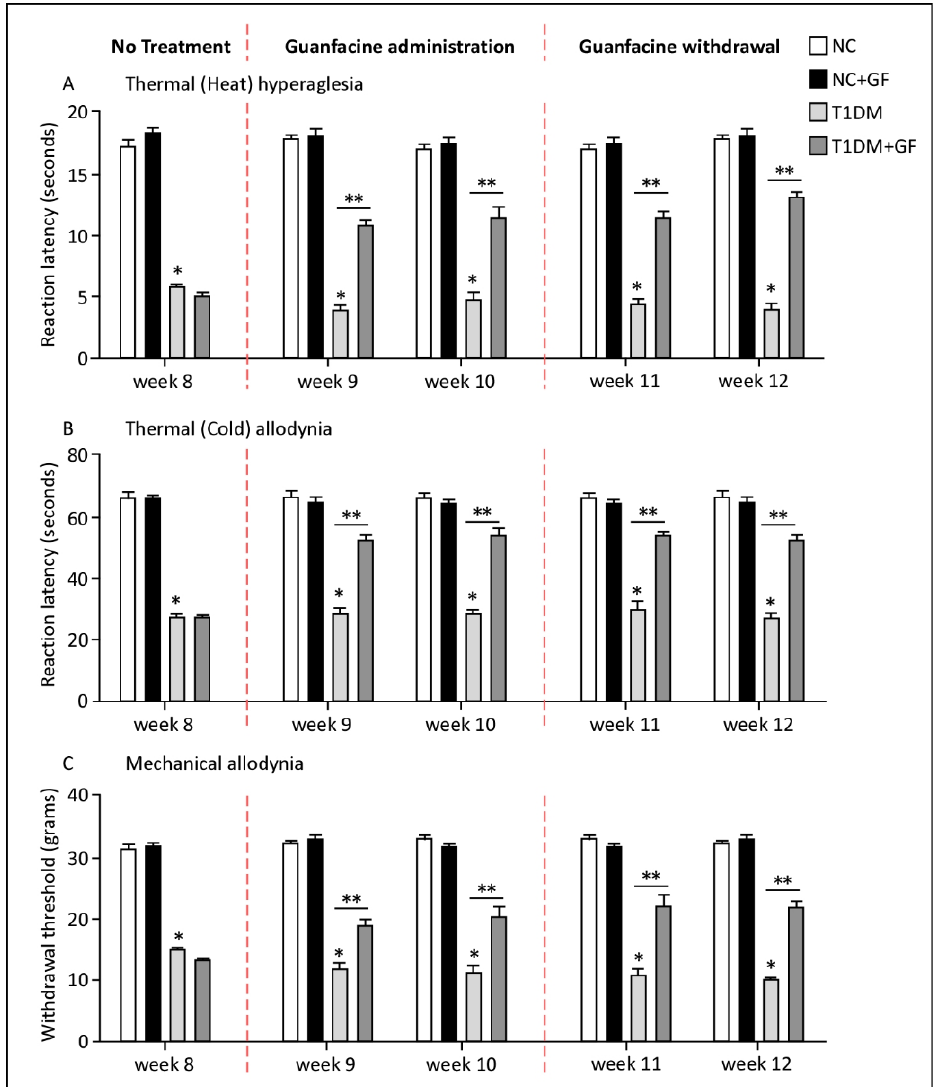
Figure 3. Persistent guanfacine analgesic effects following two weeks of withdrawal. Guanfacine (0.6 mg/Kg) was administered intraperitoneally daily for a period of two weeks. Pain transmission tests were performed at weekly interval for two weeks of guanfacine administration followed by two weeks of drug withdrawal. Data are expressed as means ± SEM obtained from five animals/group. * Significantly different from corresponding control values at p ≤ 0.05. ** Significantly different from corresponding diabetic values at p ≤ 0.05. Abbreviations: NC, Normal Control; T1DM, Type 1 Diabetes Mellitus; and GF, guanfacine.